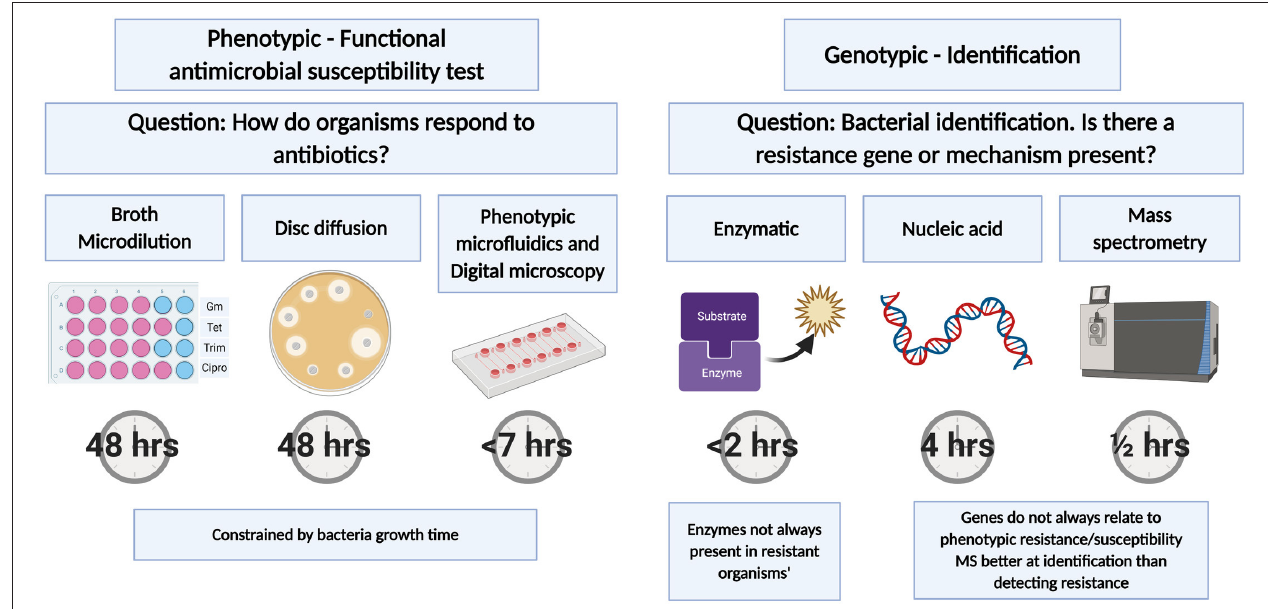
FIGURE 1 | Antimicrobial susceptibility tests. Tests can be split into phenotypic or genotypic tests with traditional AST relying on bacterial growth. Phenotypic microfluidics test times based on commercially available Accelerate PhenoTest TM BC Kit. Genotypic tests are typically faster than phenotypic tests and are more suited to bacterial identification and the identification of genes or enzymes that confer antibiotic susceptibility. Created with